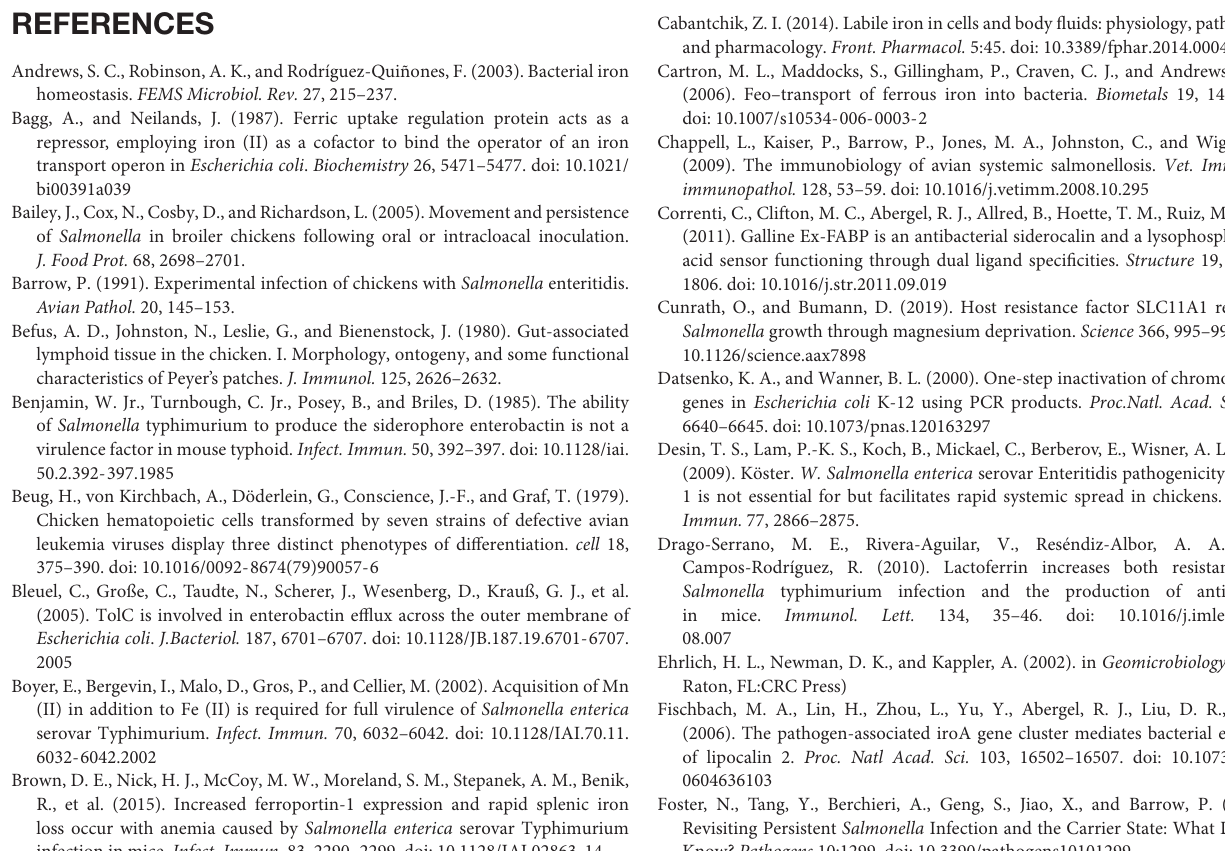
liver/spleen enrichments. Non-infected % of birds presented by shaded gray. Fisher’s exact test used for statical analysis. ns, not significant. Supplementary Figure 3 | Percentages of live and dead HD-11 cells at 24-h post infection. Triplicate of cells pooled and harvested from Cell Bind R plates after 24-h infections. 0.4% Trypan blue solution was used to differentiate dead and live cell by visualization under the microscope. Cells were counted by hemocytometer. This result is from one assay from activated HD-11 passage number 6. Supplementary Figure 4 | (A) Ex vivo imaging of the gastrointestinal tract. One-day-old SPF were orally gavage with WT c 35 lux . CmR strain. Signal intensity in counts shown in rainbow color scale. Minimum value is represented by purple color range while maximum represented by toward red color. (B) Bacterial load in the cecal content after infection from the two reporter strains of SEn. Colony counts indicated in log 10 scale. Each symbol represents a bird at a time point. Median value of the data set is shown by horizontal bar. Mean difference was accounted for statistical analysis. ns, not significant. Supplementary Figure 5 | Kinetic of lux operon expression of a siderophore null strain ( (cid:49) feo (cid:49) entB ) during a cross-feeding assay. (A) Iron deplete conditions: heat inactivated bovine calf serum with 1 mM of dipyridyl. (B) Iron replete conditions: LB medium. Luminescence measured by Victor V3 plate reader. Expression is in log scale of counts per second (CPS).) Starting culture were grown in LB and adjusted to OD600 = 1. Mixed: wildtype to (cid:49) feo (cid:49) entB ( (cid:49)(cid:49) ) ratio of 1. Assay was performed in triplicates for four times. Each line represents a technical replicate. Arrow indicates the cross-feeding event. (C) Maximum luminescence value (Lumi max ) by each reporter. Maximum CPS values obtained from (B) . Each symbol represents a technical replicate. Mean differences were analyzed